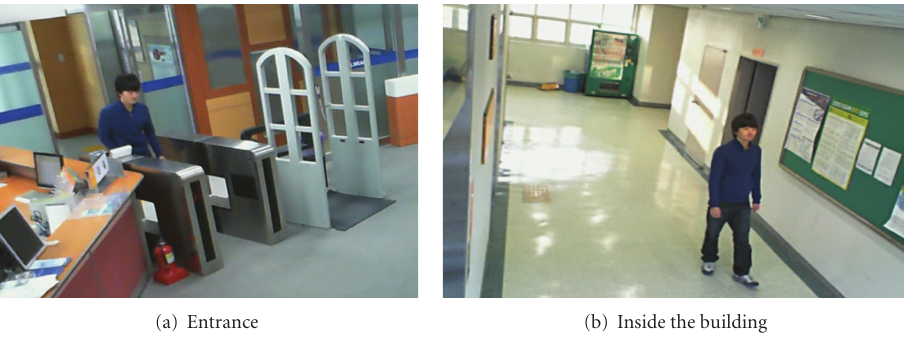
Figure 11: Experimental environment of the proposed